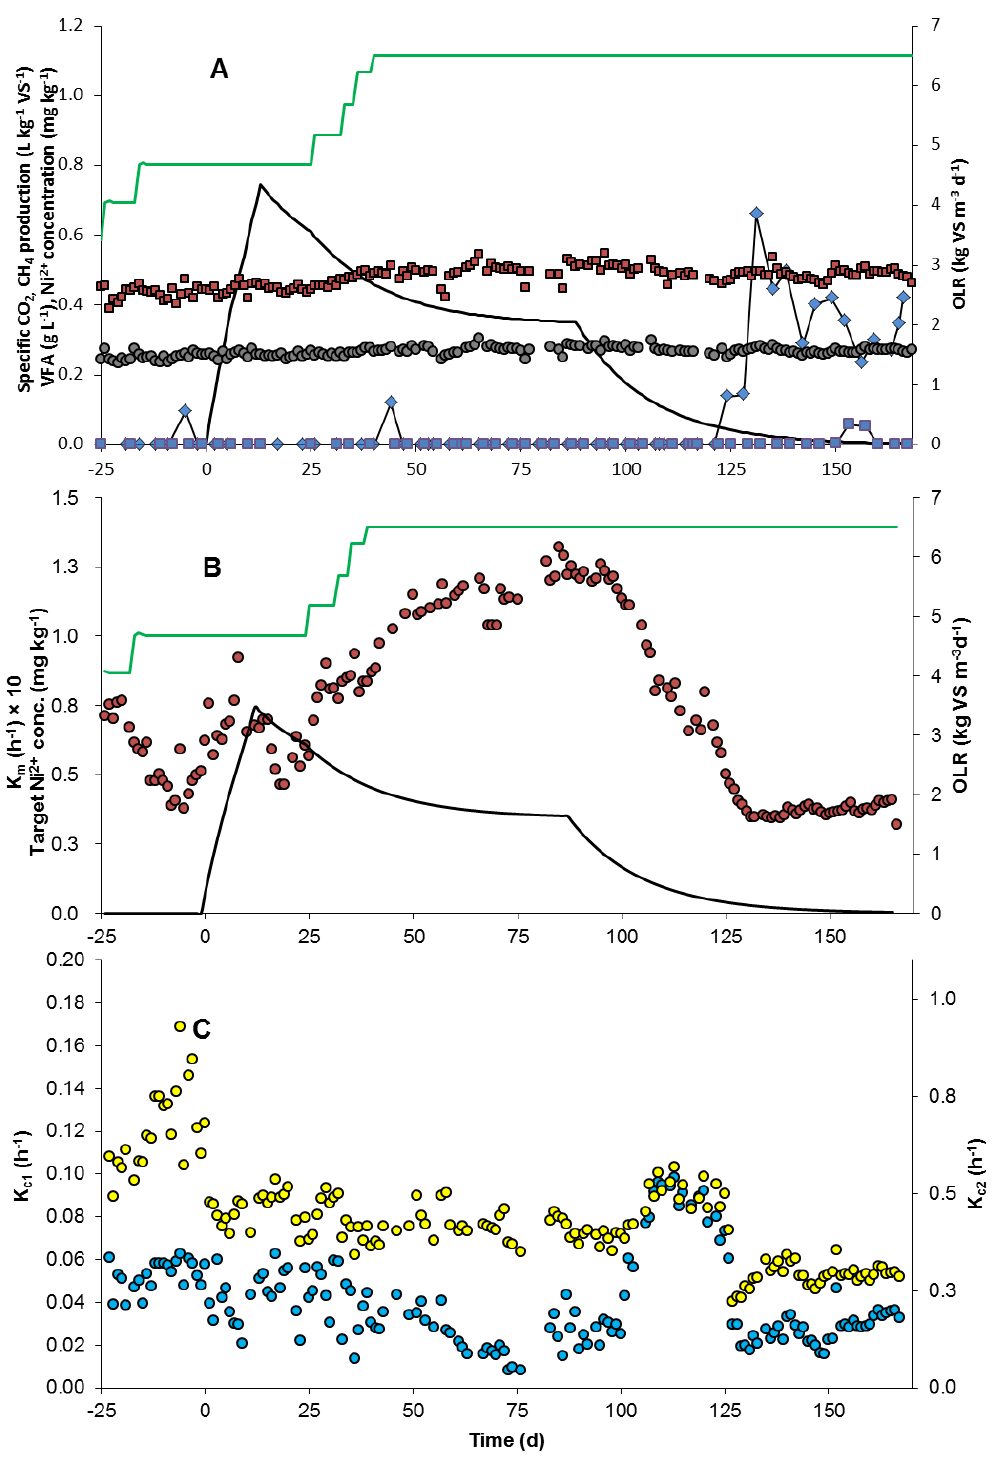
Figure 1. Process performance and kinetics for the reactor during the experiment. ( A ) Organic loading rate (OLR) (▬),specific methane (CH 4 ) production (■), specific carbon dioxide (CO 2 ) production (●), calculated added nickel (Ni) concentration in the reactor (▬), acetate concentration (♦) and propionate concentration (■); ( B ) Rate constant of methane formation ( k m , multiplied by a factor of 10 for graphical reasons) (●), OLR (▬) and nickel concentration in the reactor (▬); ( C ) Rate constant of slow carbon dioxide formation, k c1 (●) and rate constant of fast carbon dioxide formation, k c2